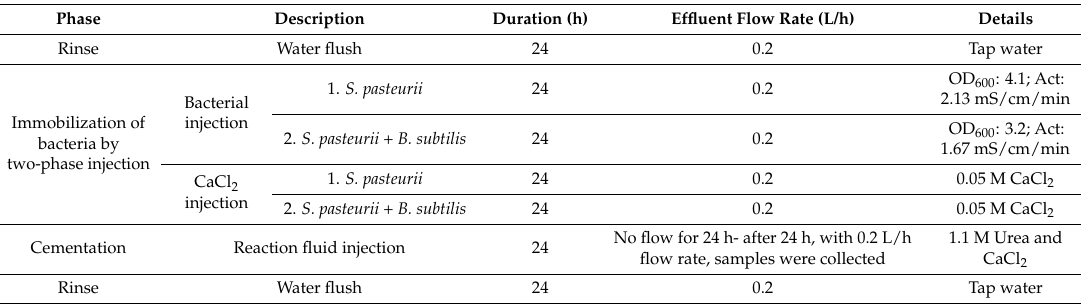
Table 1. Overview of the column injections for determining microbial carbonate precipitation under monoculture experiment and coculture